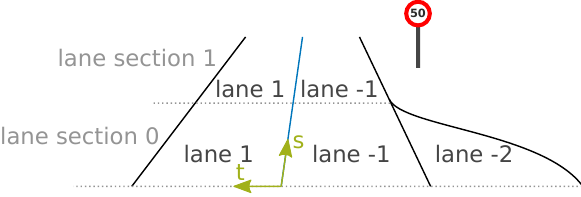
Figure 3. Road divided into lane sections and individual